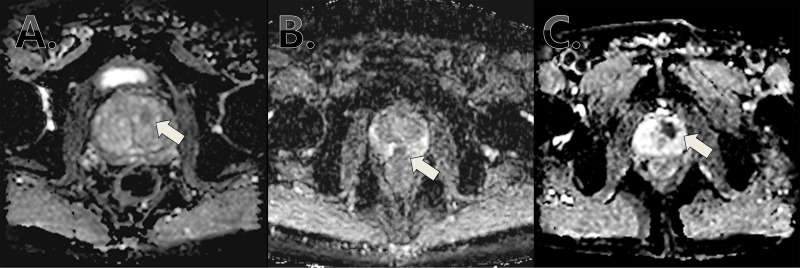
The examples of diffusion weighted images according to the Likert score; (A) grade III; (B) grade IV; (C) grade V.